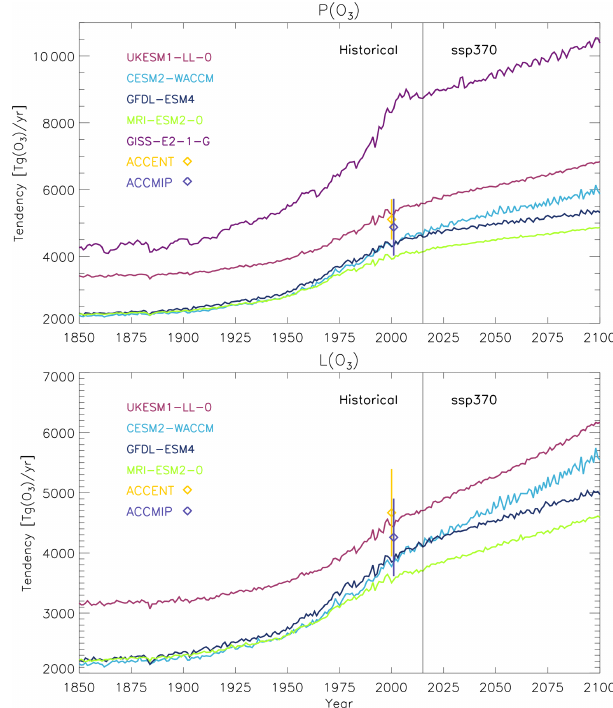
Figure 15. Evolution of ozone chemical production ( P ) and chemi- cal loss ( L ) terms over the period 1850–2100 for the five CMIP6 models (except L from GISS-E2-1-G). ACCENT and ACCMIP production and loss are also displayed for the year 2000, with a slight shift for display purposes.